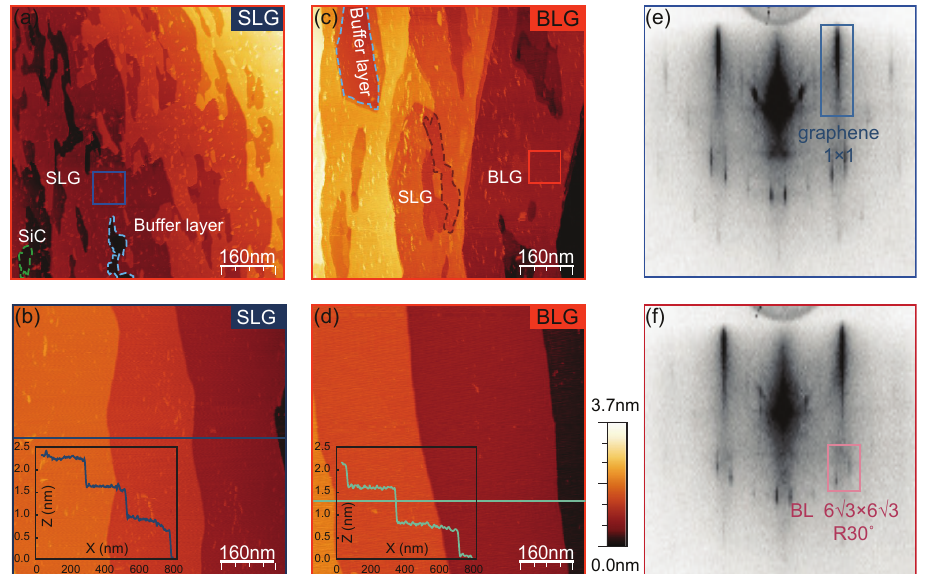
Figure 2. The changes of sample surface morphology through nitrogen plasma treatment. ( a , c ) STM images of SLG and BLG prepared by only flash annealing. The SiC and buffer layer coexisting with SLG are indicated by green and blue dashed line circles respectively in panel ( a ), the buffer layer and SLG coexisting with BLG are indicated by blue and brown dashed line circles respectively in panel ( c ). ( b , d ) STM images of SLG and BLG prepared by nitrogen plasma annealing after pre-flash annealing. The SLG and BLG show the consistent terrace height profiles (lower-left-corner insets in panels ( b , d ), respectively). ( e , f ) The RHEED patterns of SLG and BLG treated with nitrogen plasma, with electron beam along (cid:104) 1120 (cid:105) azimuth. Scanning parameters for STM: V s = 1 V, I t = 100 pA, room